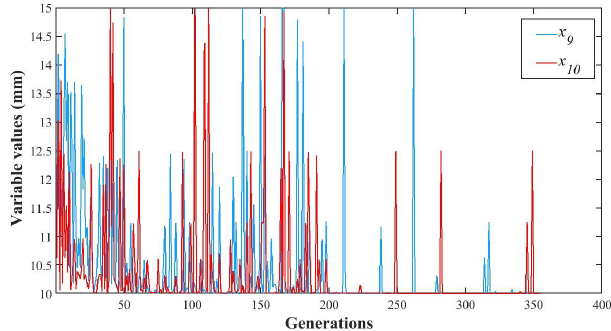
Figure 18. Variations of the objective function under different num- bers of